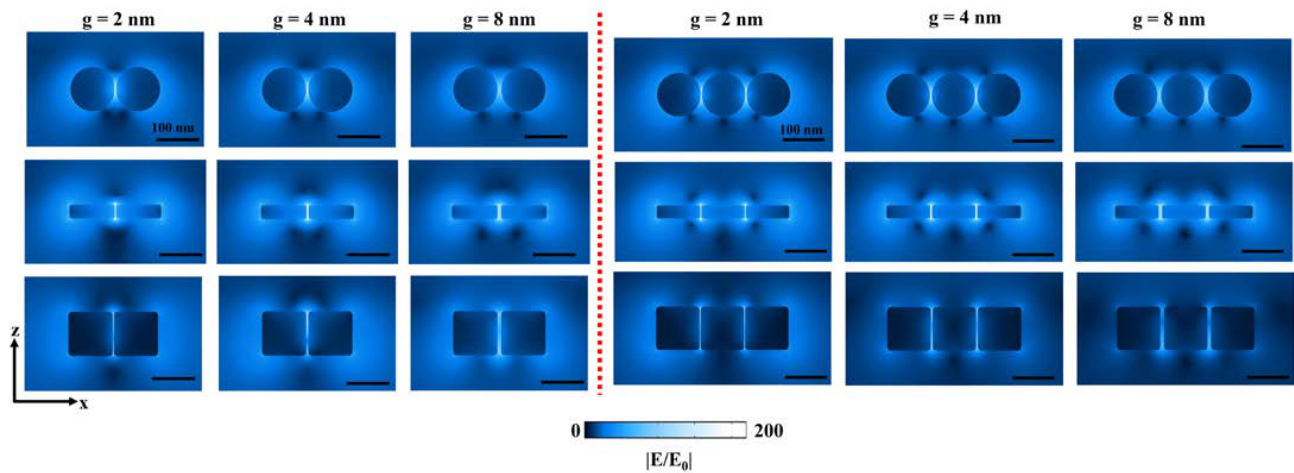
Figure 3. Cross-section XZ electric field profiles taken at g = 2 nm, 4 nm, and 8 nm for a dimer ( left ) and trimer ( right ) nanostructures studied in this work. Better near-field enhancement can be observed from sphere- and disk-based nanostructures when compared to a cube. Electric field profiles are scaled to the same color strength for a fair comparison. All scale bars measure 100 nm.